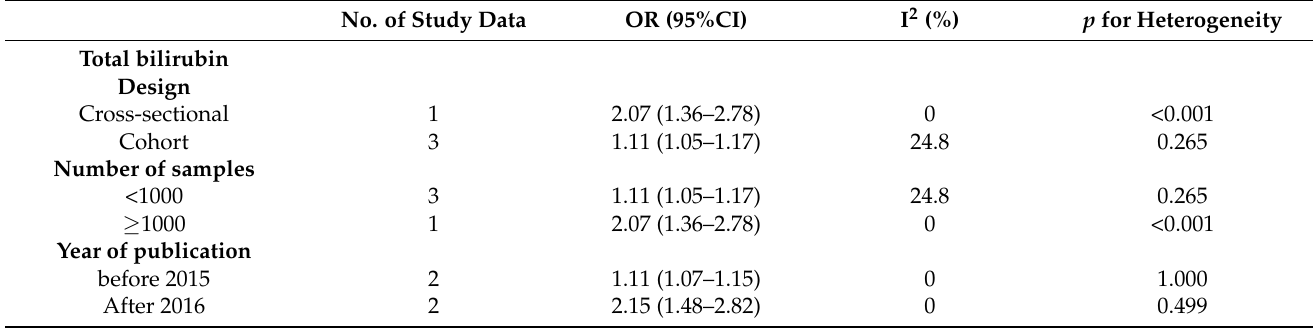
Figure 2. A forest plot of the association between total bilirubin and stroke severity [7,16,20]. Table 2. A subgroup analysis of bilirubin and ischemic stroke